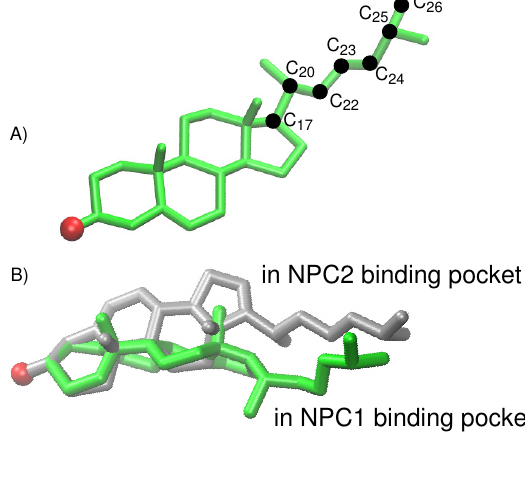
Figure 9. ( A ) Model of cholesterol with carbon atoms (green) involved in tail isomerization indicated with black dots (oxygen atom shown in red). ( B ) Comparison of the cholesterol conformations in the binding pockets of the California model, NPC1(NTD) (green) and the NPC2 (gray).